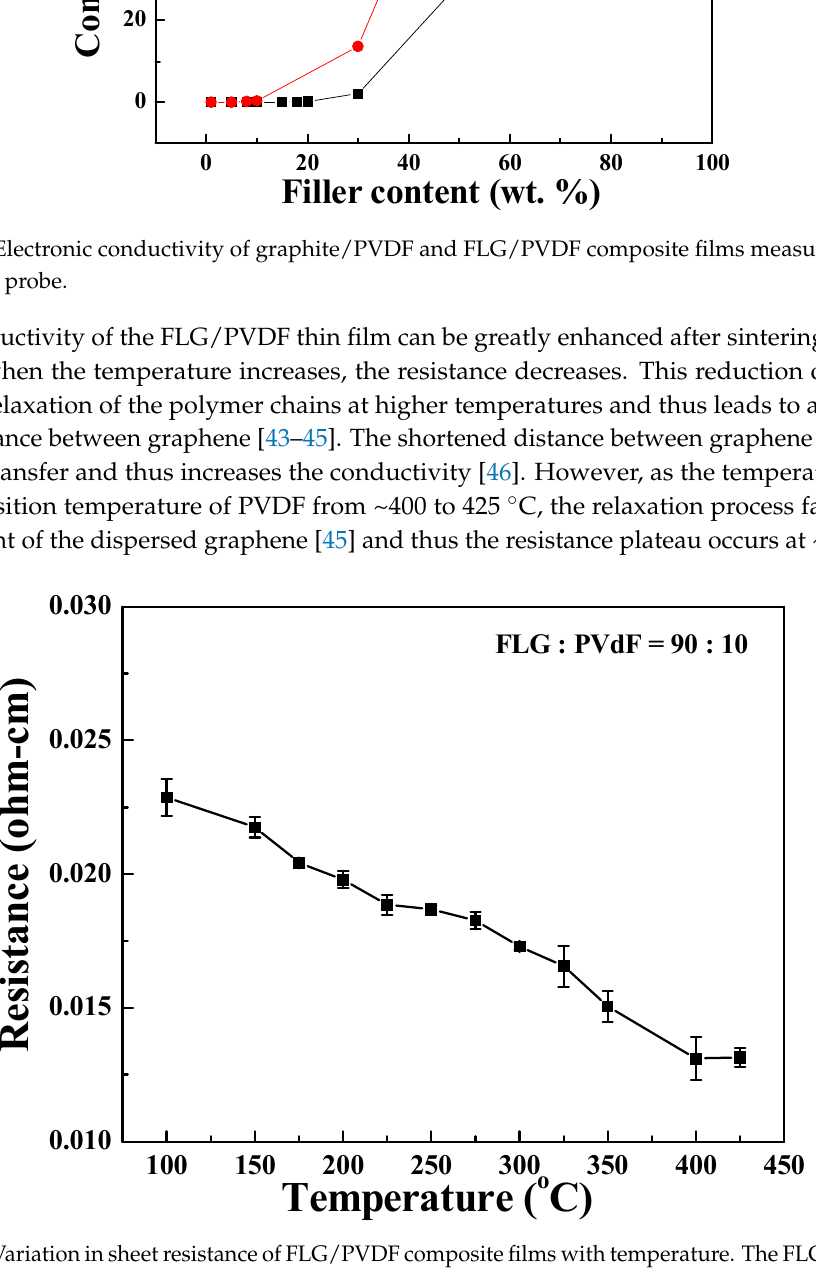
Figure 4. Variation in sheet resistance of FLG/PVDF composite films with temperature. The FLG/PVDF thin film is coated on glass with a thickness of 0.02 mm and is placed on a hot plate for 30 min.